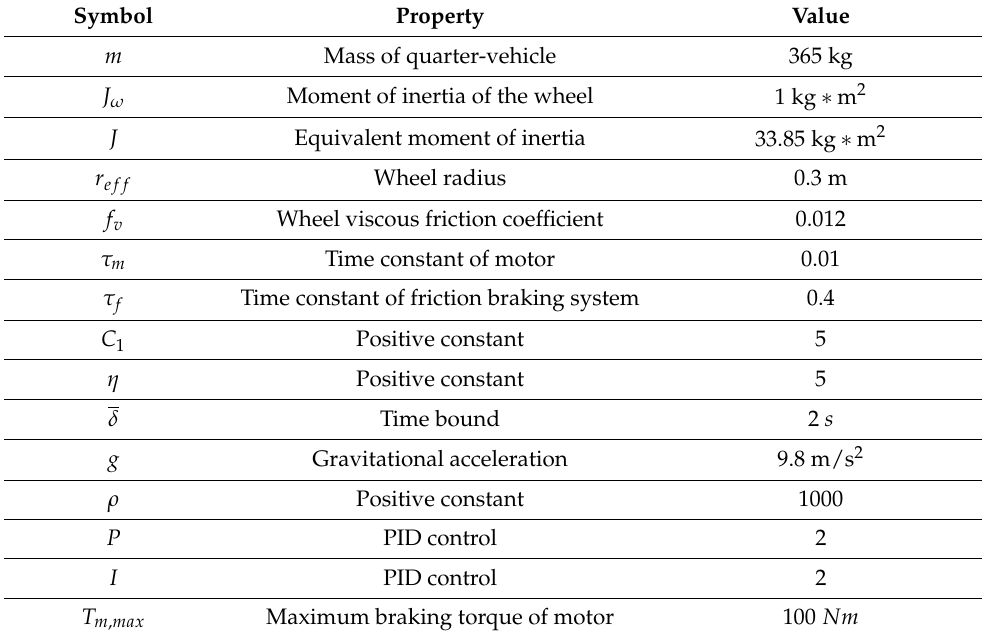
Table 1. System parameters.